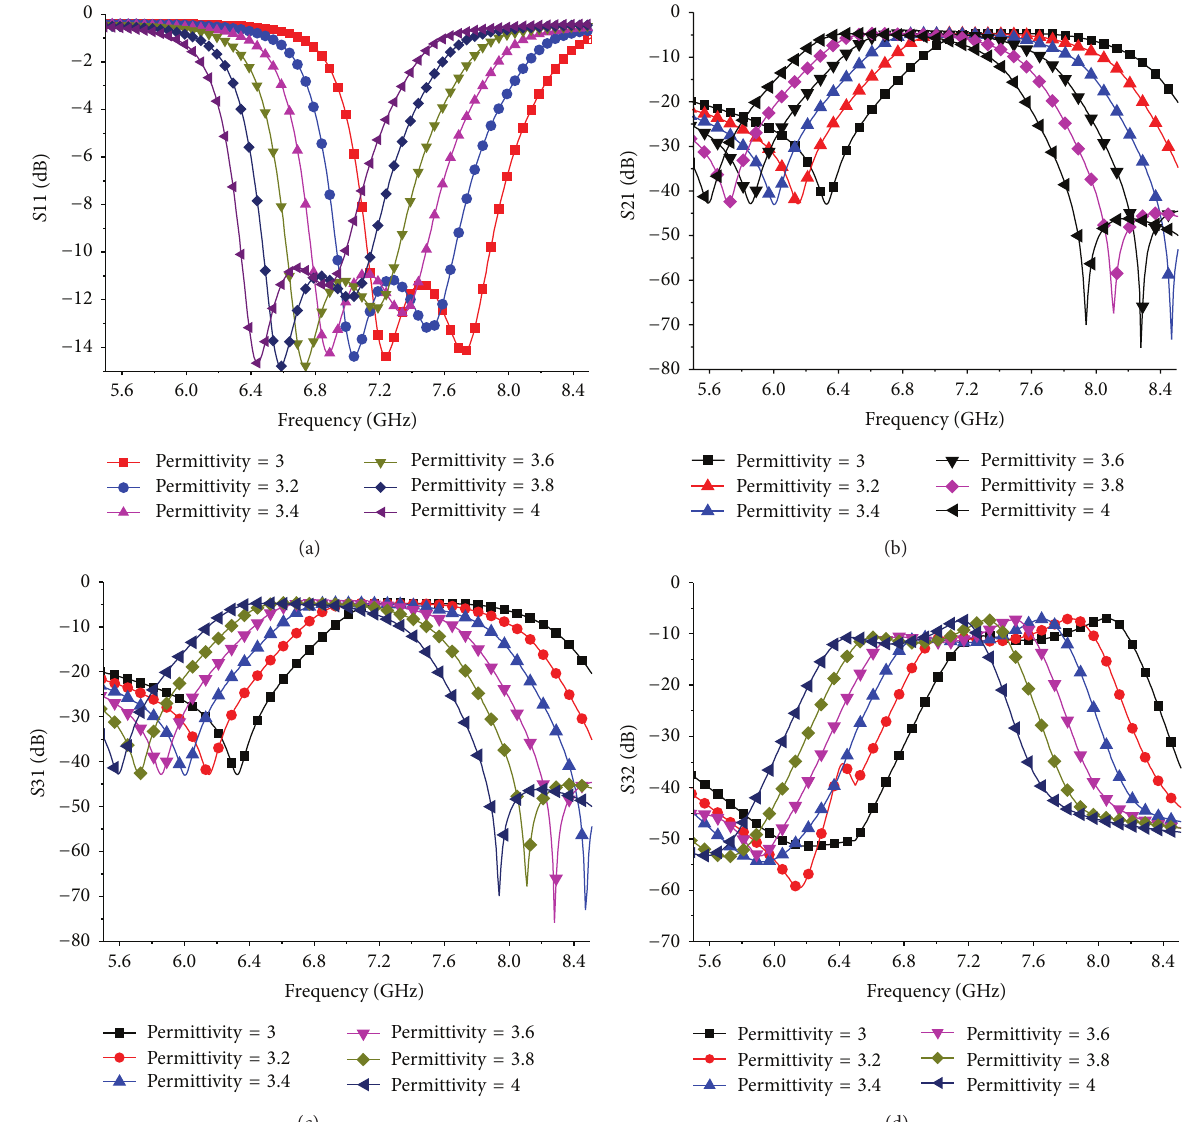
Figure 8: Simulated S-parameters with different LC permittivities. (a) S11; (b) S21; (c) S31; (d)